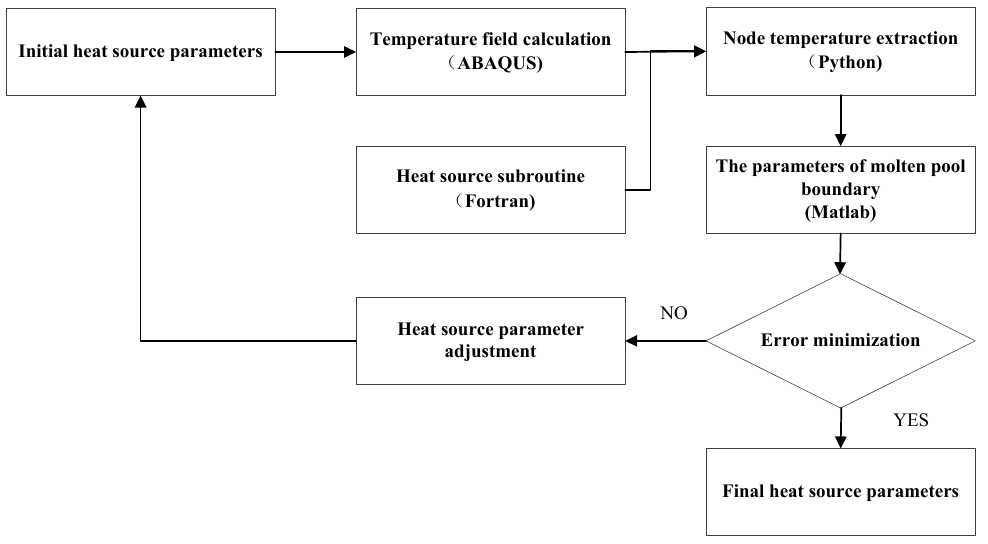
8 of 20 Figure 7. Double-ellipsoidal heat source model.